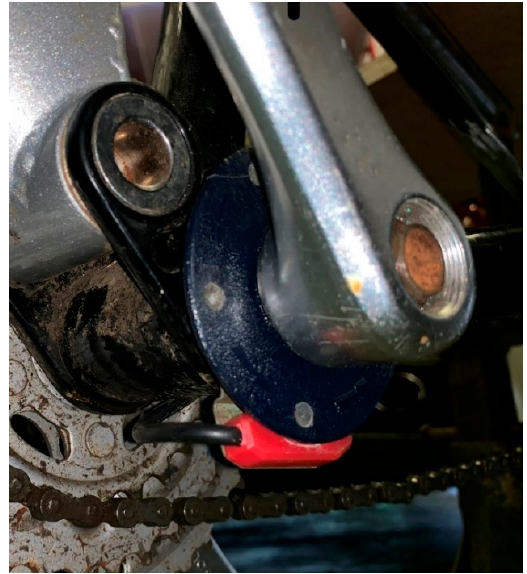
Figure 15. Cadence sensor assembly.